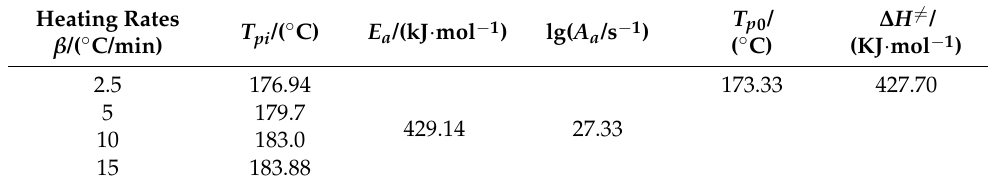
Figure 5. DSC experiments of NPTO · 2H 2 O at different heating rates. Table 2. Thermodynamic parameters of the thermal decomposition process of